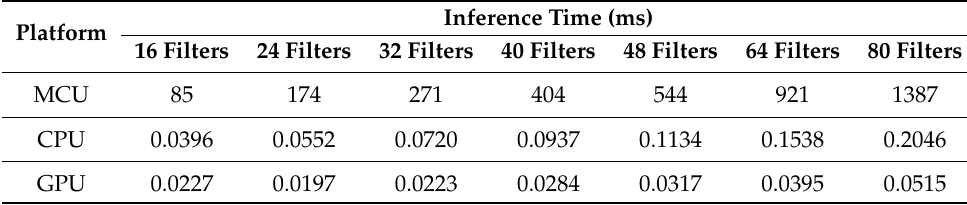
Table A2. Comparison of 32-bit floating-point inference time for a single input on a microcontroller, a CPU and a GPU. Neural network architecture is described in Section 6 with several filters per convolution layer varying from 16 to 80 and dataset is described in Section 6.1.1. For CPU and GPU, inference batch size is set to 512 and the dataset is repeated 104 times to try to compensate for the large startup overhead compared to the total inference time. Measurements are averaged over at least 5 runs.